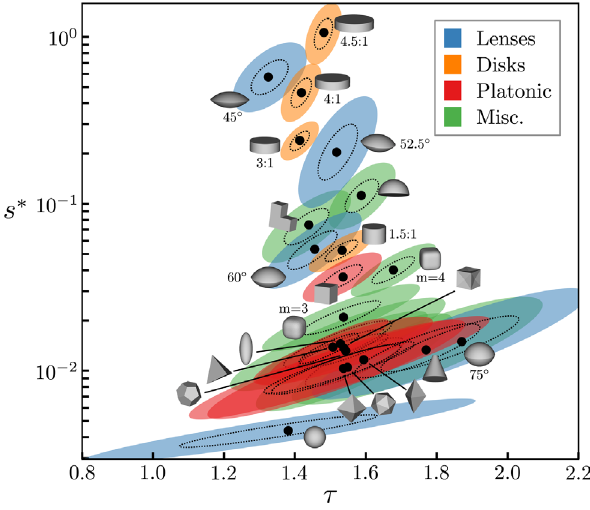
FIG. 6. Parameter space for the truncated power-law fits to D ð s Þ . The dotted (solid) ellipses around each best fit ð τ ; s (cid:2) Þ are the 1 σ ( 2 σ ) confidence regions as determined by the nonpara- metric bootstrap method.